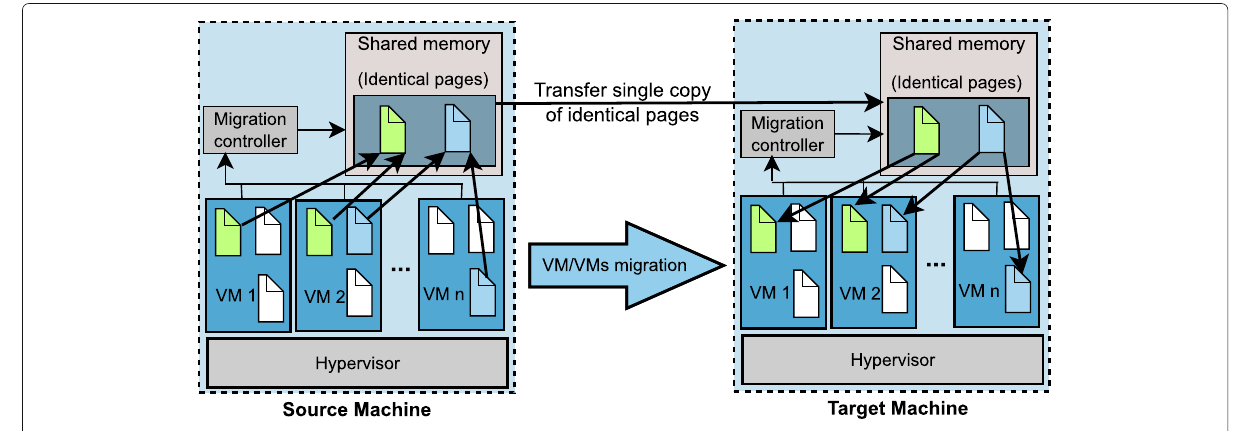
Fig. 7 Generic steps of single/multiple VM migration